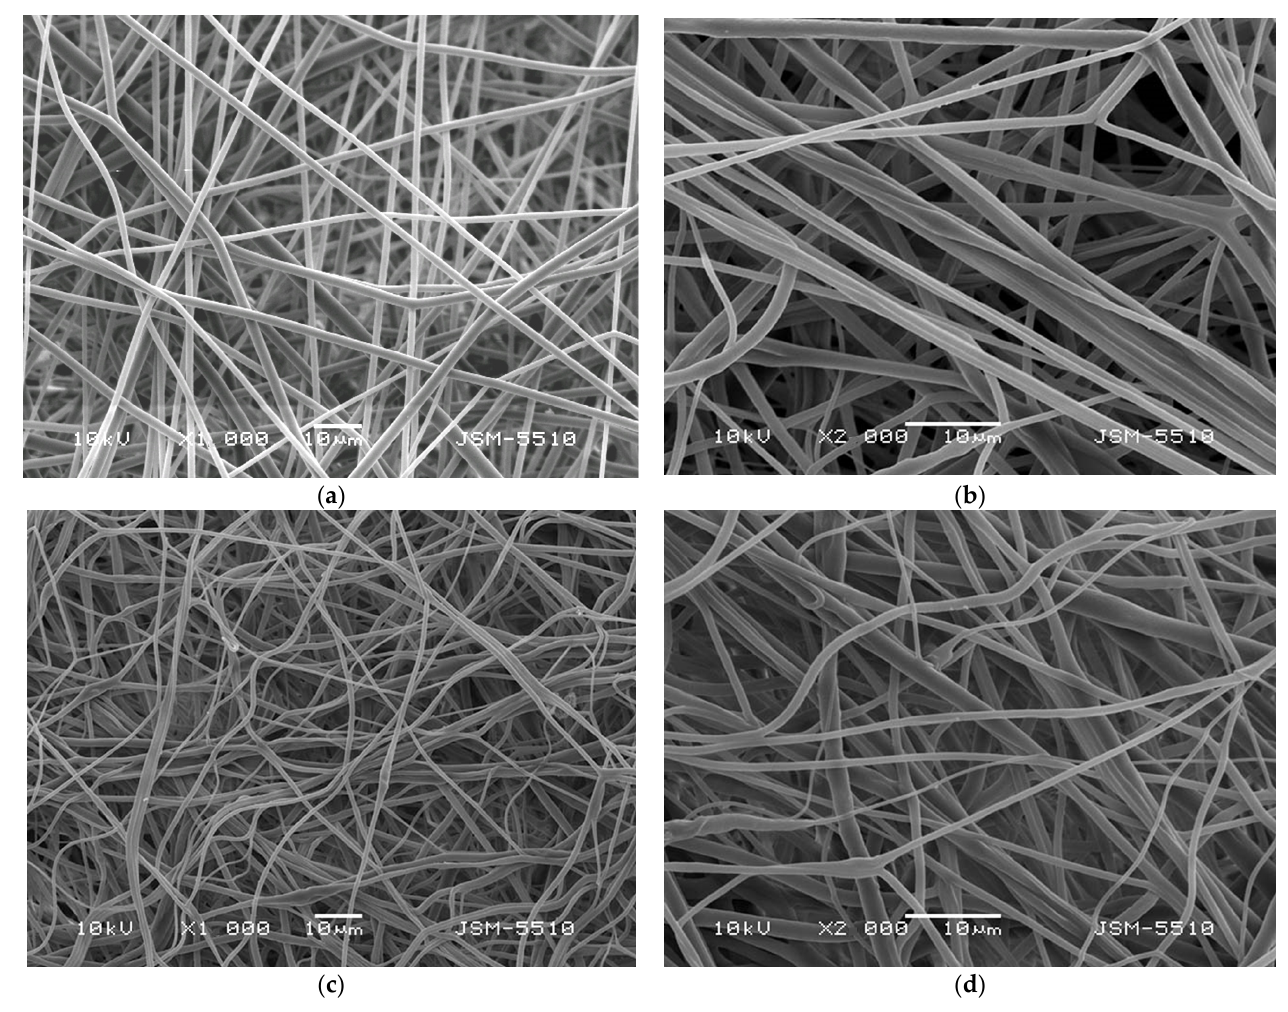
Figure 2. SEM images of: ( a , b ) PLA fibrous mat and ( c , d ) PLA/ P. oleracea fibrous mat at magnifica- tions ×1000 ( a , c ) and ×2000 ( b , d ). × 1000 ( a , c ) and × 2000 ( b , d